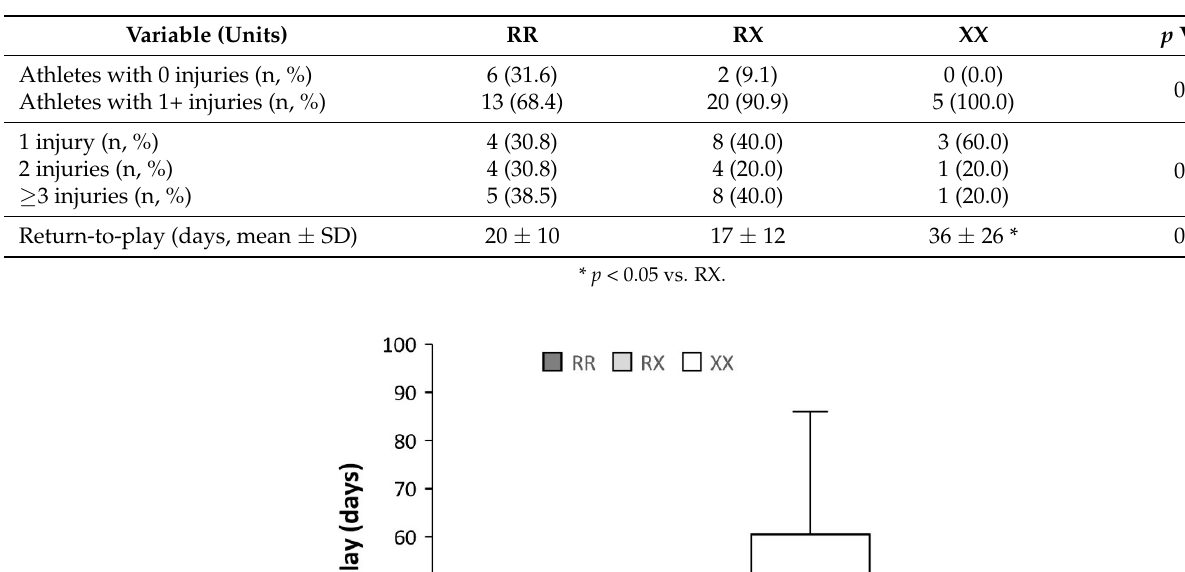
Table 2. Muscle injuries during a 5-year period and α -actinin-3 ( ACTN3 ) R577X genotype.